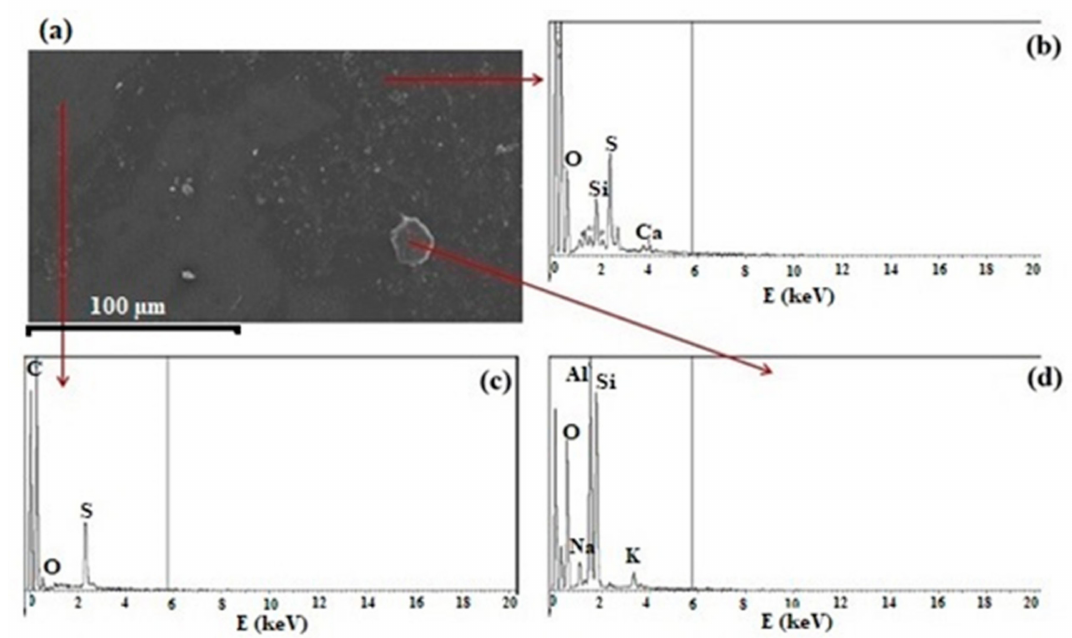
Figure 3. SEM image ( a ), and EDS spectra of black area ( b ), white area ( c ) and gray area ( d ) of membrane surface.